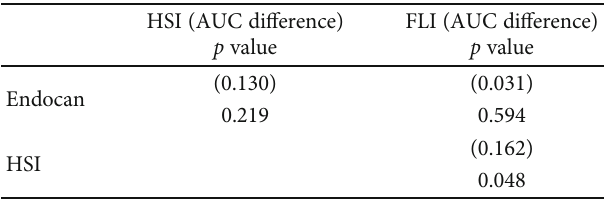
Figure 1: Sensitivity and speci fi city parameters for serum endocan, HSI, and FLI in patients of NAFLD. HSI: hepatic steatosis index; FLI: fatty liver index; NAFLD: nonalcoholic fatty liver disease. Table 4: The comparative assessment of AUC for endocan, HSI, and